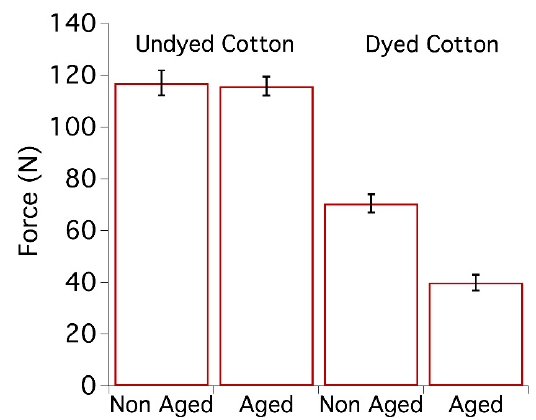
Figure 1. Maximum force at break of model cotton samples, undyed and dyed with iron-tannate dyes before [67] and after 10 years of natural ageing. From 5 to 10 tensile measurements per sample were carried out.